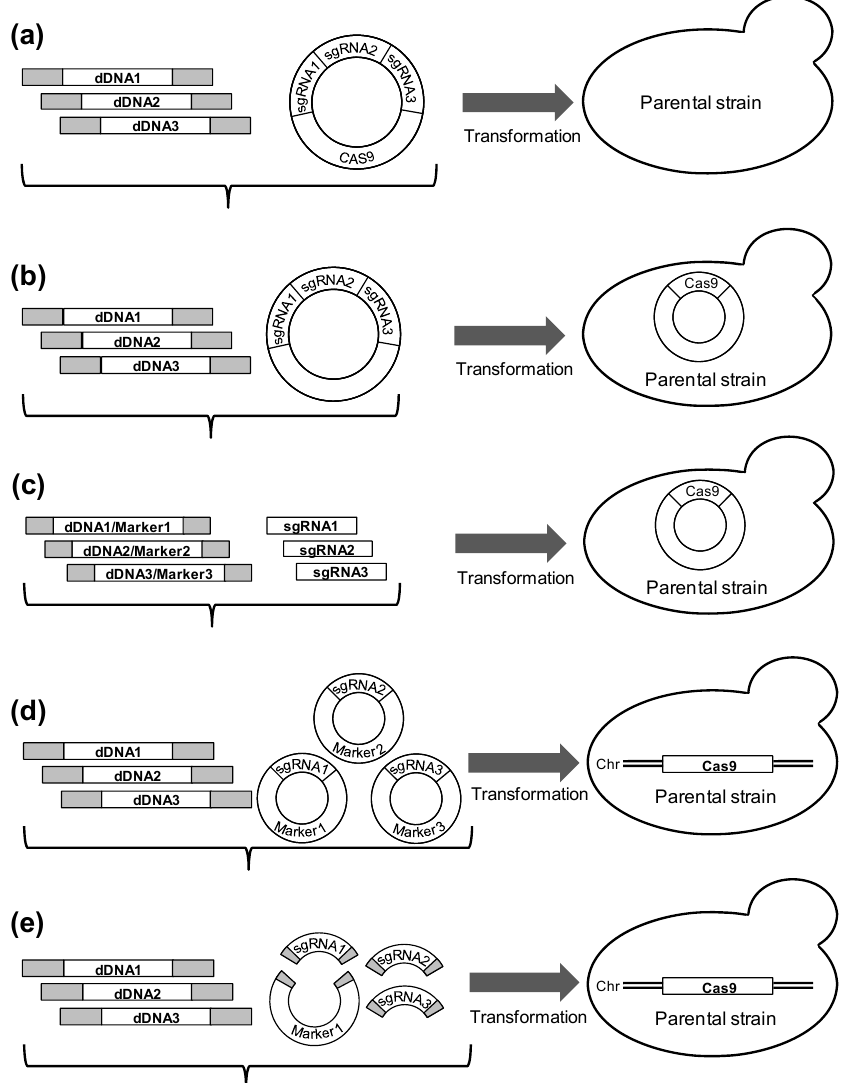
Figure 1. Several experimental designs for CRISPR/Cas9-mediated multiple integration. dDNA, donor DNA; sgRNA, single guide RNA. ( a ) Transformation of a recipient strain with a single plasmid bearing all sgRNA cassettes and Cas9 cassette [8,9]; ( b , c ) Construction of an intermediate strain bear- ing the Cas9 plasmid and transformation of this strain with a plasmid containing three sgRNA expres- sion cassettes [5,7] ( b ), or with the linear DNA fragments encoding sgRNA expression cassettes [10] ( c ); ( d ) Co-transformation of the strain constitutively expressing Cas9 with three separate plasmids containing sgRNA expression cassettes and different selective markers [6]; ( e ) Co-transformation of the strain constitutively expressing Cas9 with a linearized vector and three linear sgRNA expression cassettes resulting in assembling of sgRNA plasmids in cells due to gap repair